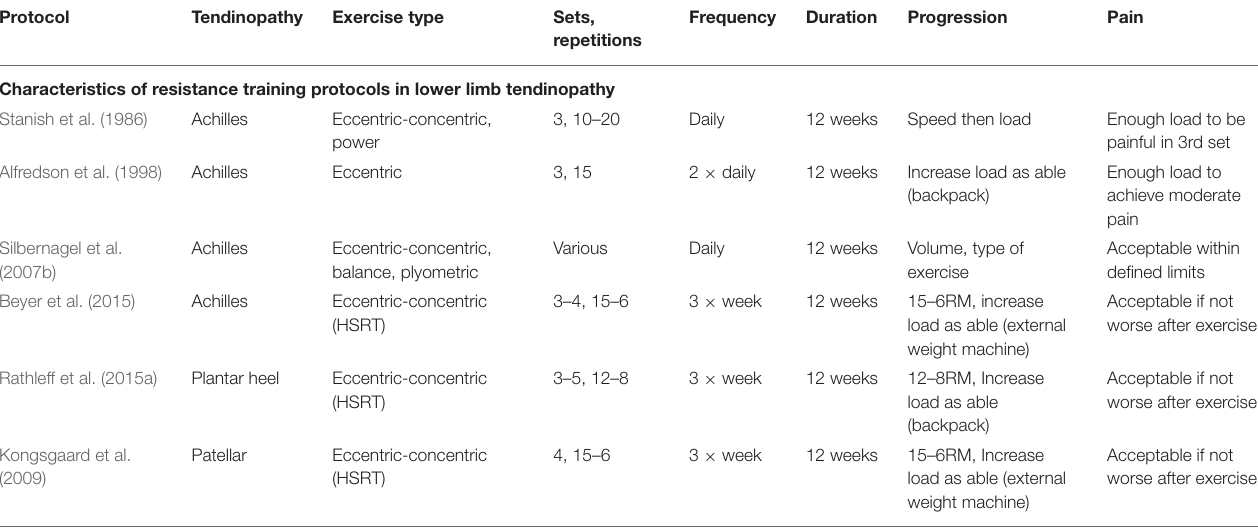
TABLE 1 | Evidence-based resistance training protocols in lower limb tendinopathy. Protocol Tendinopathy Exercise type Sets,